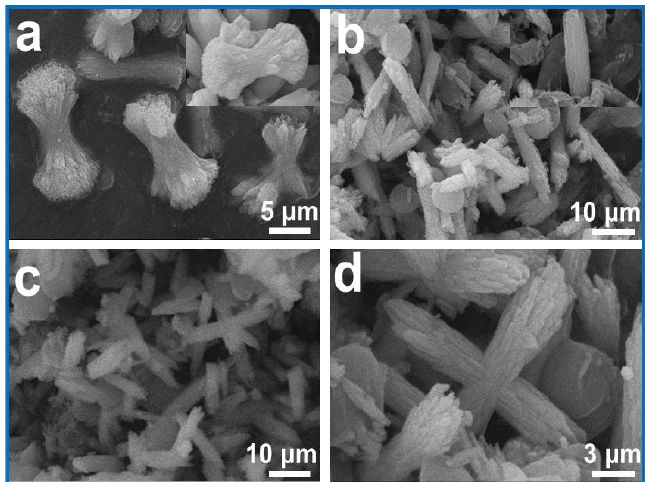
Figure 3. Typical SEM images of SrCO 3 obtained under a nano-MMT concentration of 2 mL / L when the mineralization times were 6 h ( a ), 12 h ( b ), ( c , d ) 18 h, respectively.